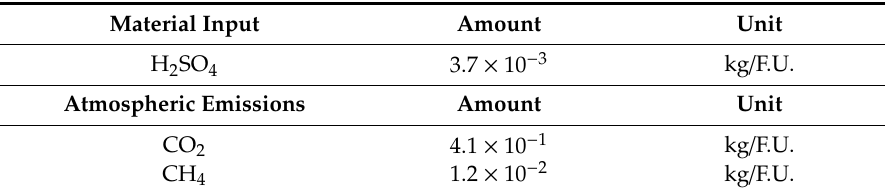
is set 2% of the total mass to reduce the number of inputs to be reported. Complete information can be found in the Supplementary